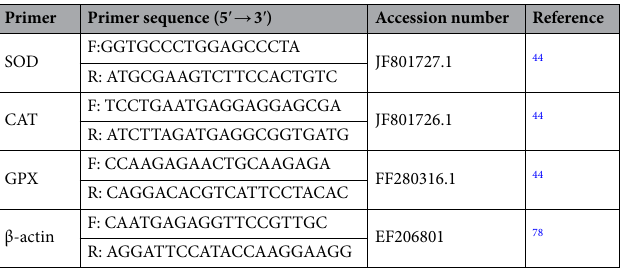
Table 1. Sequences of used